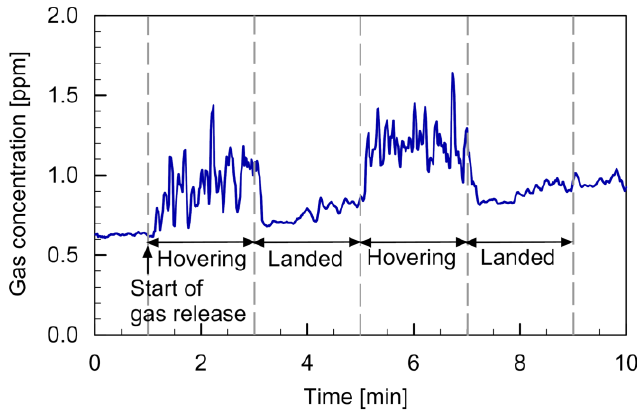
Figure 6. Time course of the PID reading recorded in the gas detection experiment.